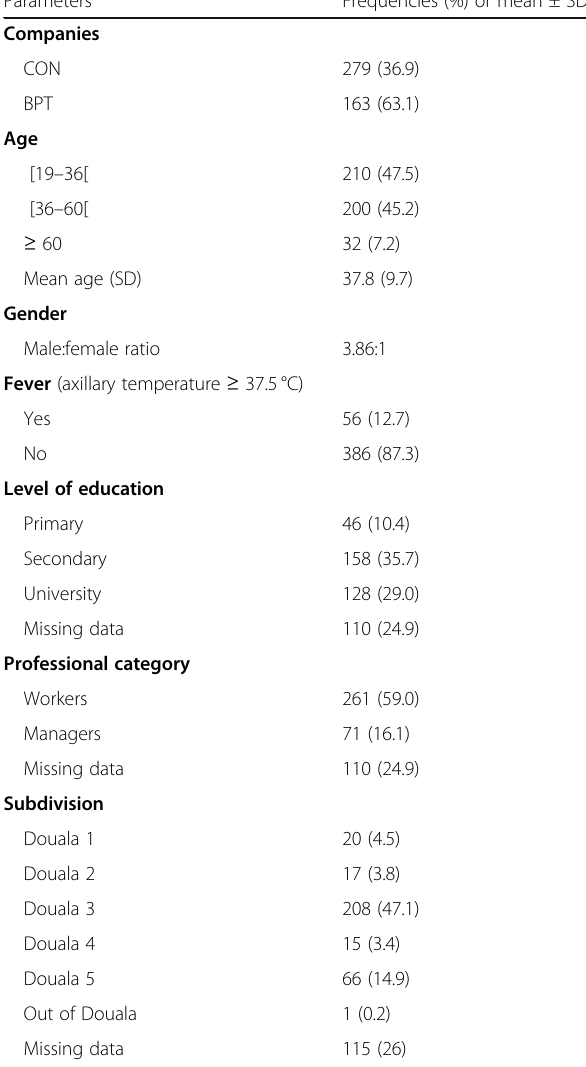
Table 1 Baseline characteristics of study population Table 2 Malariometric variables using light microscopy